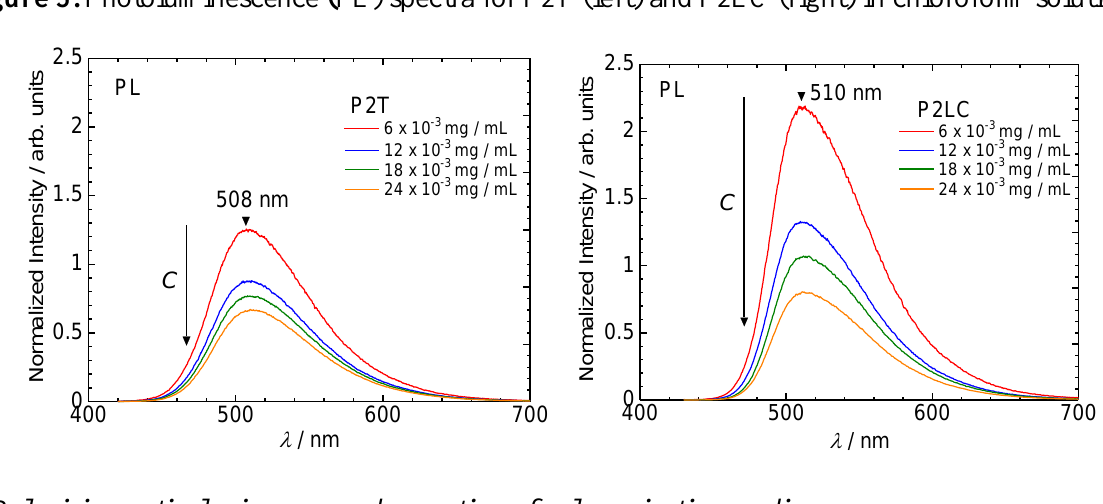
Figure 5. Photoluminescence ( PL) spectra for P2T (left) and P2LC (right) in chloroform solutions.